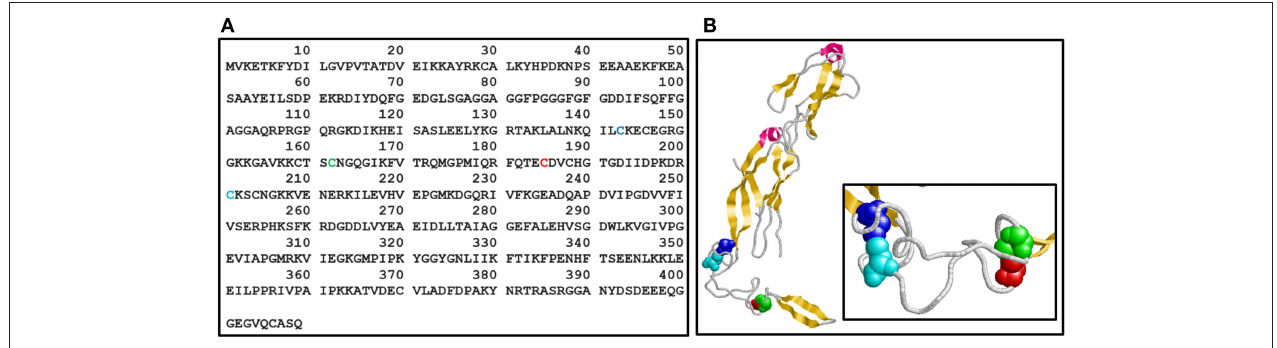
FIGURE 1 | Ydj1 structure. (A) Primary structure. Amino acid sequence of Ydj1 (UniProtKB - P25491) from Saccharomyces cerevisiae . (B) Tertiary structure. Crystal structure of the Ydj1 monomer (residues 110-337; PDB 1NLT). The Cys residues in each Zn binding domain (ZBD) are shown in a space-filling model: Cys143 (blue) and Cys-201 (cyan) in ZBDI and Cys162 (green) and Cys185 (red) in ZBDII [the same colors are also used in (A) ]. Pink, alpha-helix; yellow,